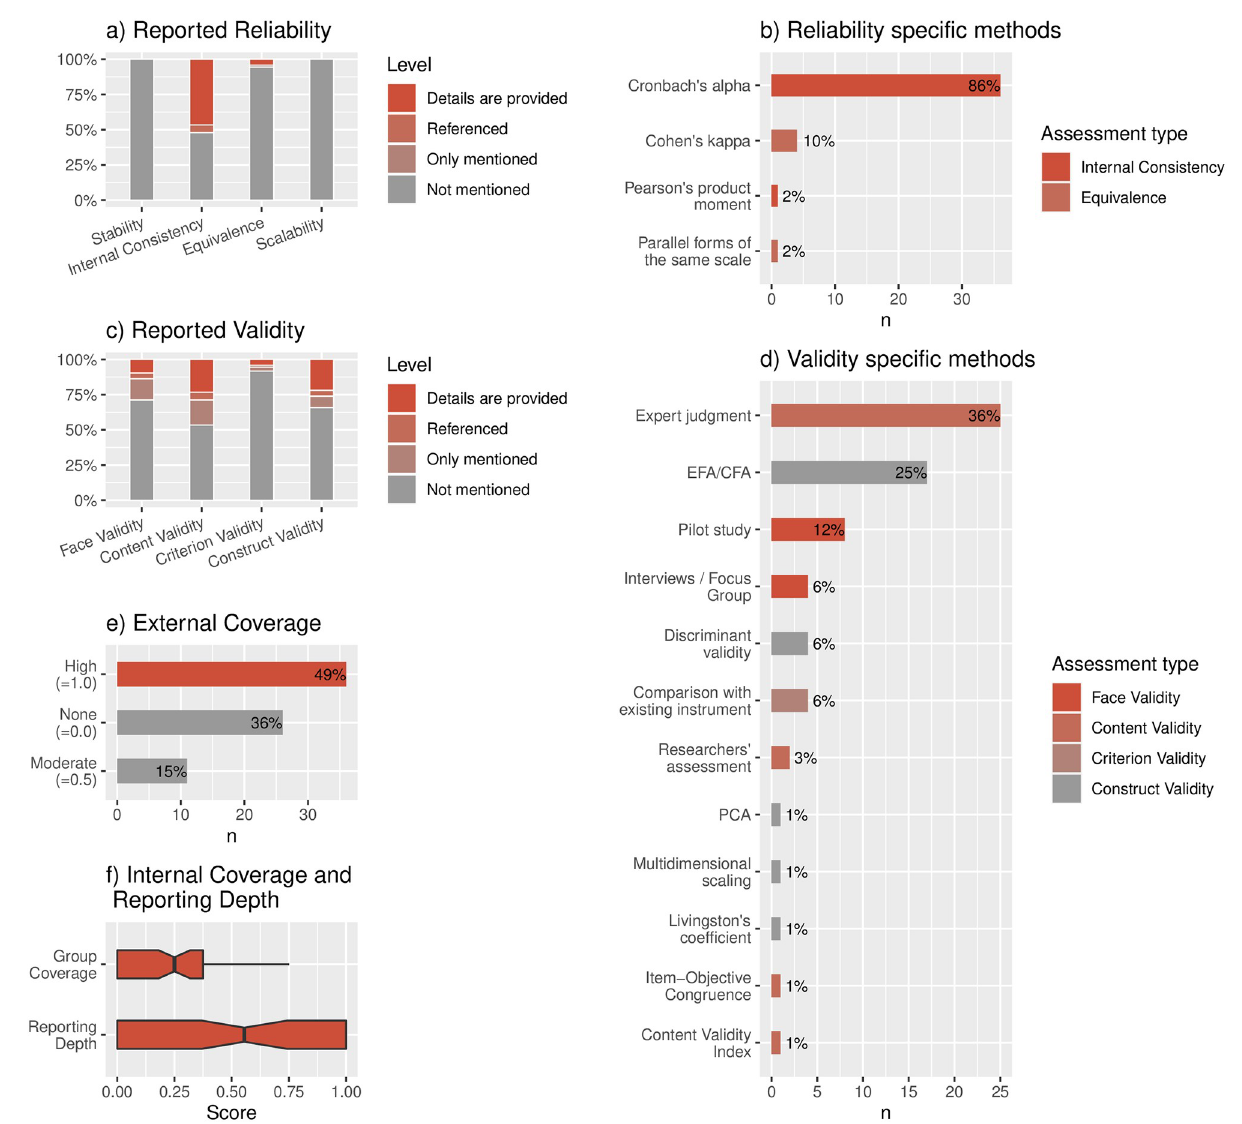
Fig 4. Reporting practices of quality assessments.